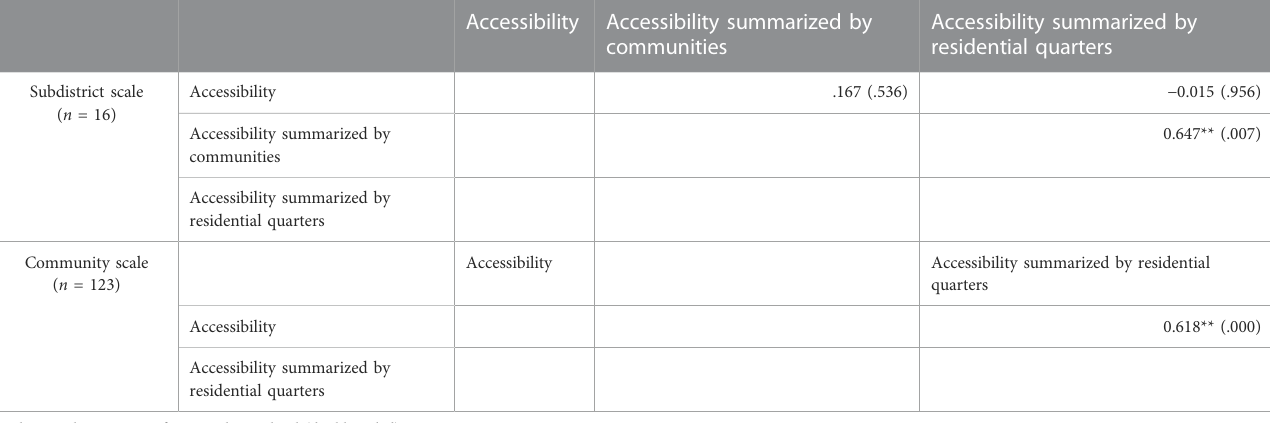
TABLE 2 Spearman ’ s correlation coef fi cient ( p -value) between accessibility at subdistrict and community scales, and the corresponding weighted summary results.